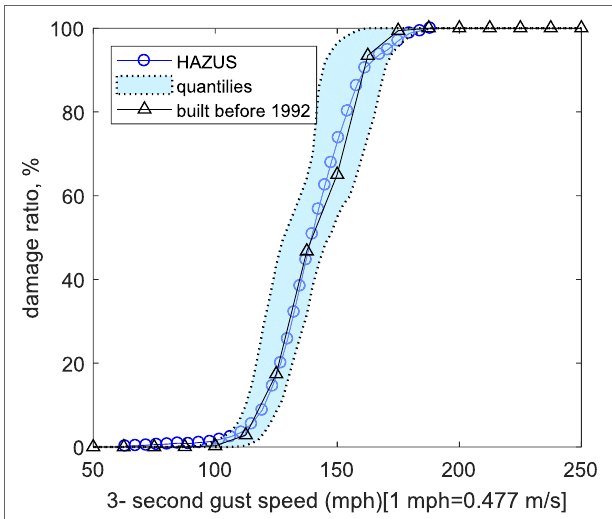
FigUre 3 | The vulnerability of the house structure built before hurricane